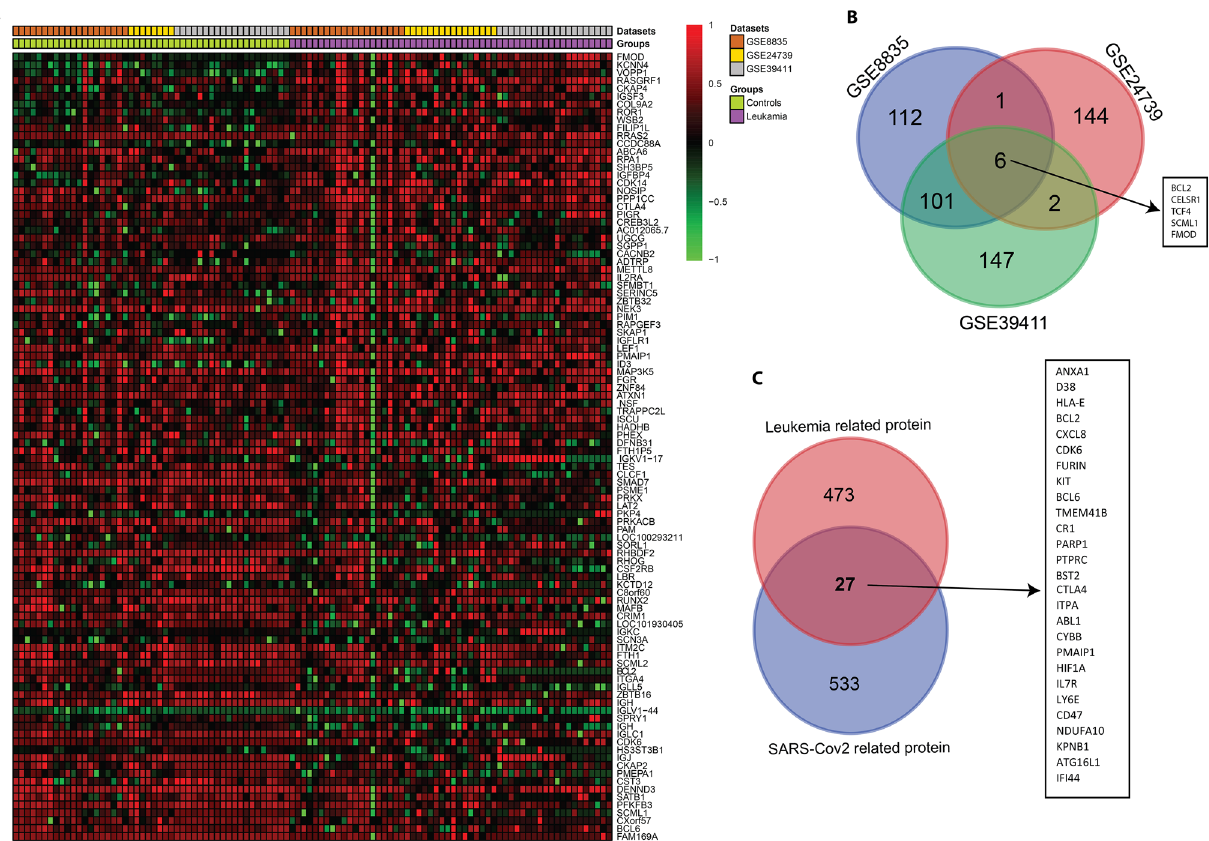
Fig. 2 A Expression heatmap showing expression levels of signifi- cant DEGs for the GSE8835, GSE24739, GSE39411 datasets. Color indicates high expression (red) and low expression (green). B Venn diagram showing the DEGs in GSE8835, GSE24739, and GSE39411